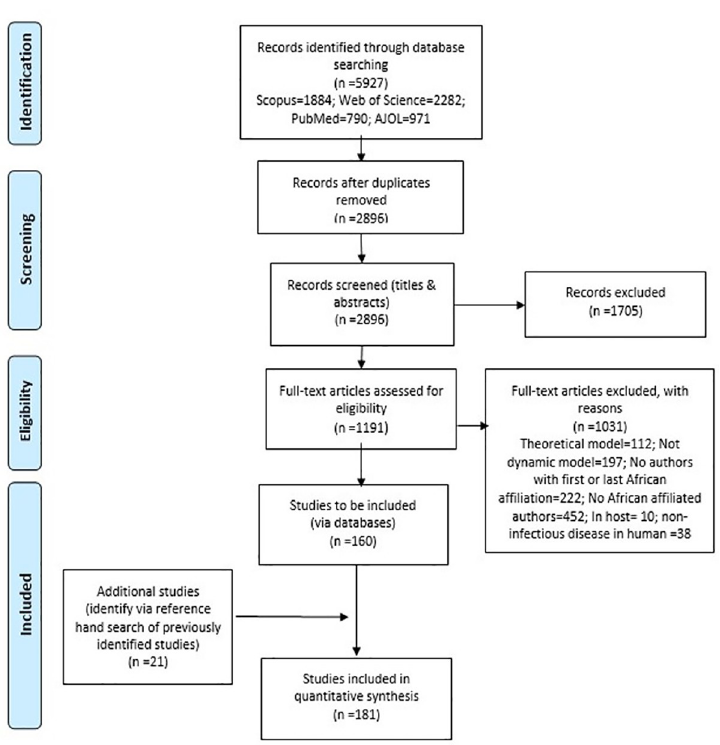
Fig 2. Flow chart illustrating the identification, screening, eligibility, and inclusion of literature for the scoping review process.